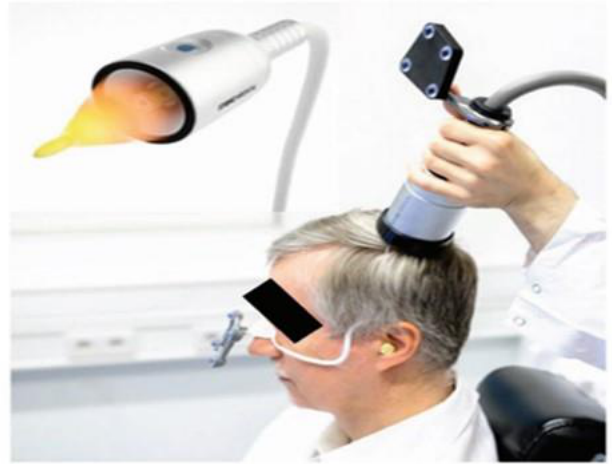
Figure 3. Courtesy image from Beisteiner et al. (2020) [15]. Transcranial pulse stimulation with ul- trasound in treating Alzheimer’s disease— a new navigated focal brain therapy. Advanced Science, 7(3), 1902583-N/a. and TPS machine with MRI in QMH, HKU Department of Psychiatry. The interventionist used the TPS handpiece over the partici pants’ skull, such that the participants’ fMRI T1 brain images could be visualized and projected in real-time. The